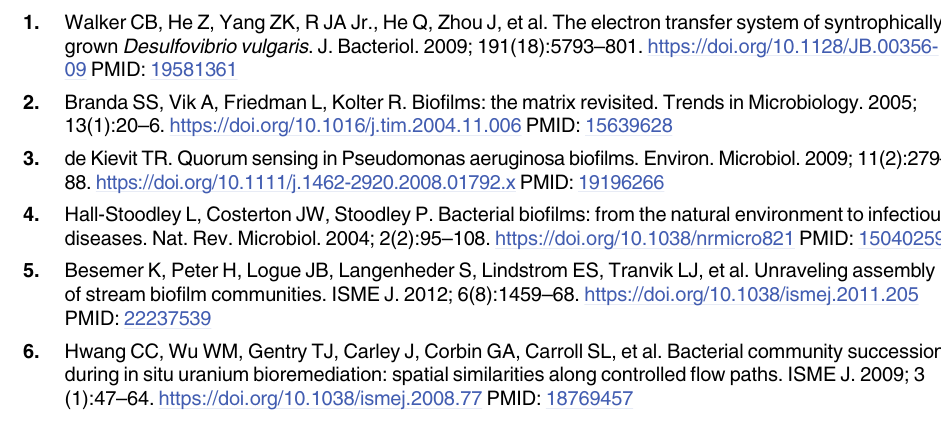
S2 Fig. Source and reacted groundwater physical properties. Physical properties of source (dashed line) and reacted groundwater in bioreactors of filtered (open square) and unfiltered (closed square) groups. S3 Fig. Source and reacted groundwater anionic properties. Anionic properties of reacted groundwater in bioreactors of filtered (open square) and unfiltered (closed square) groups. S4 Fig. Reacted groundwater organic acid concentrations. Variation of organic acids of reacted groundwater in bioreactors of filtered (open square) and unfiltered (open square)